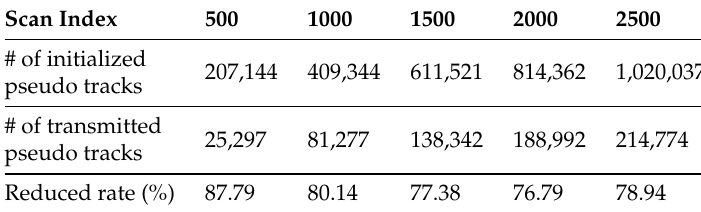
Table 1. Total number of initialized and transmitted pseudo tracks in sonar s 2 at case 1.